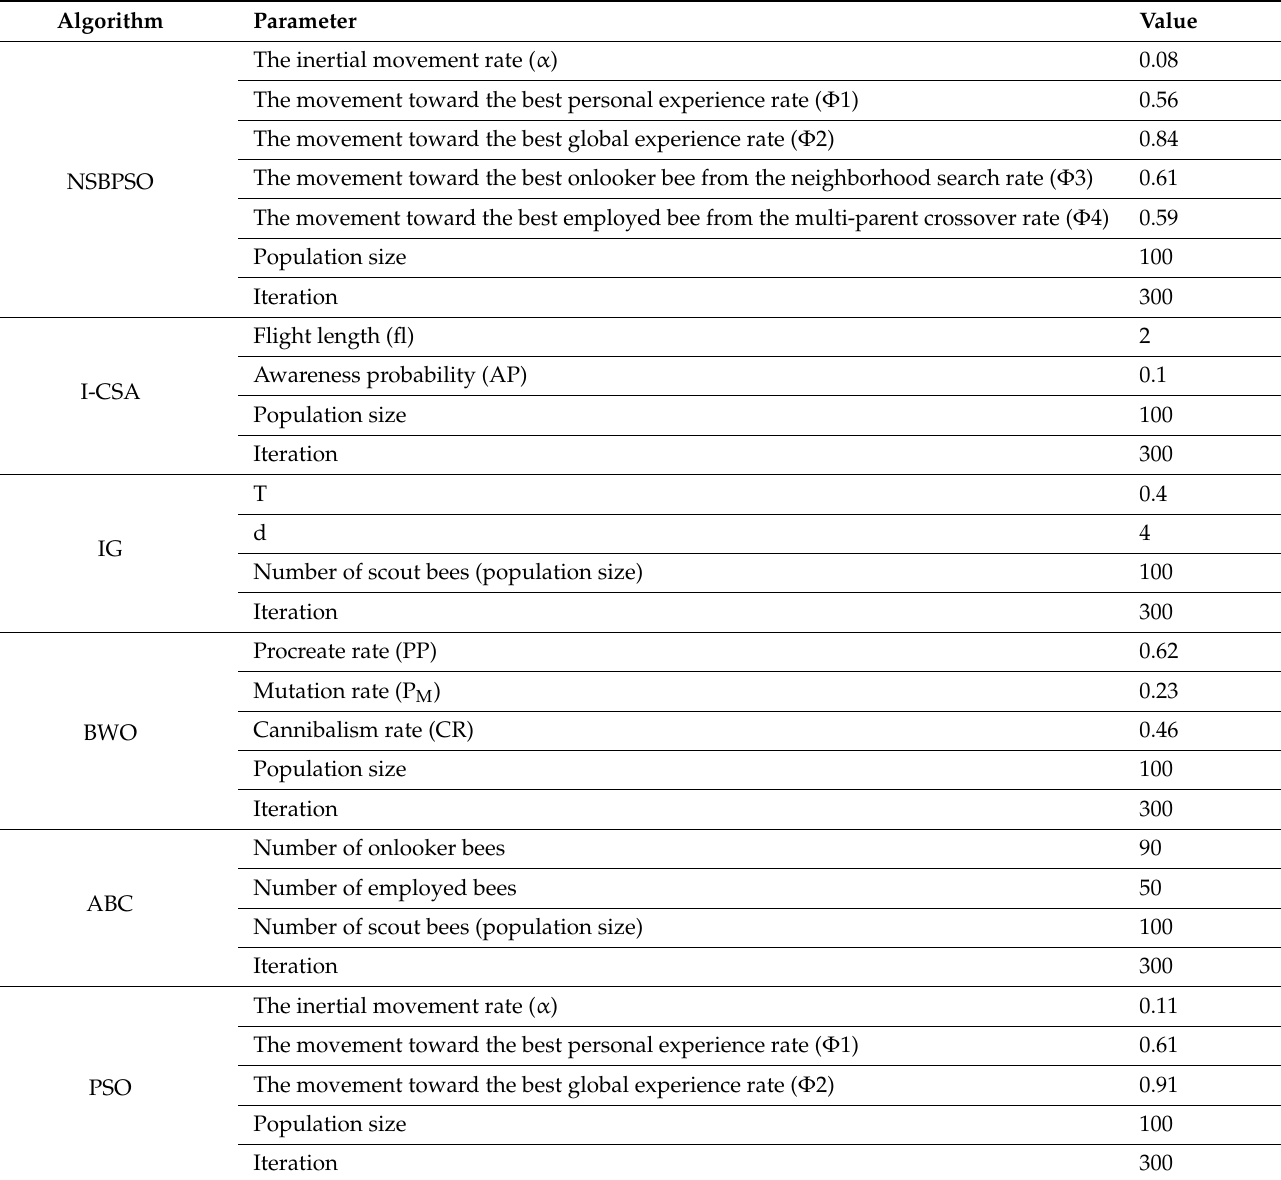
Table 2. The parameters settings of the